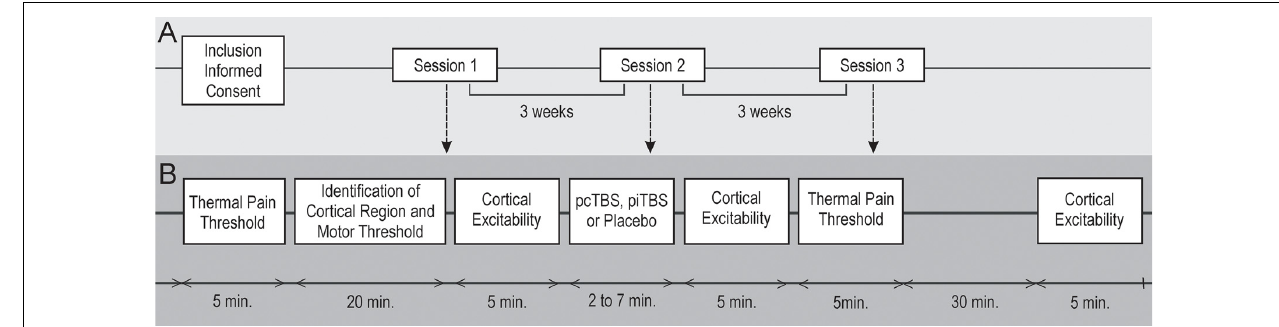
FIGURE 1 | Schematic overview of the whole study. A double-blind, cross-over study. Three prolonged theta-burst stimulation (pTBS) sessions (A) were carried out in random order with a minimum 3-week wash-out period. Healthy subjects ( n = 24) were randomly assigned to a sequence of three pTBS conditions (B) over the right M1 cortex: continuous pTBS (pcTBS); intermittent pTBS (piTBS); placebo pTBS (plcTBS). Cortical excitability (CE) changes in resting motor thresholds (RMTs) and absolute motor-evoked potential (MEP) amplitudes were assessed before and at two time-intervals (0–5 min; 40–45 min) after pTBS. Tactile and thermal pain thresholds quantitative sensory tests (QST) were measured before and 5 min after pTBS